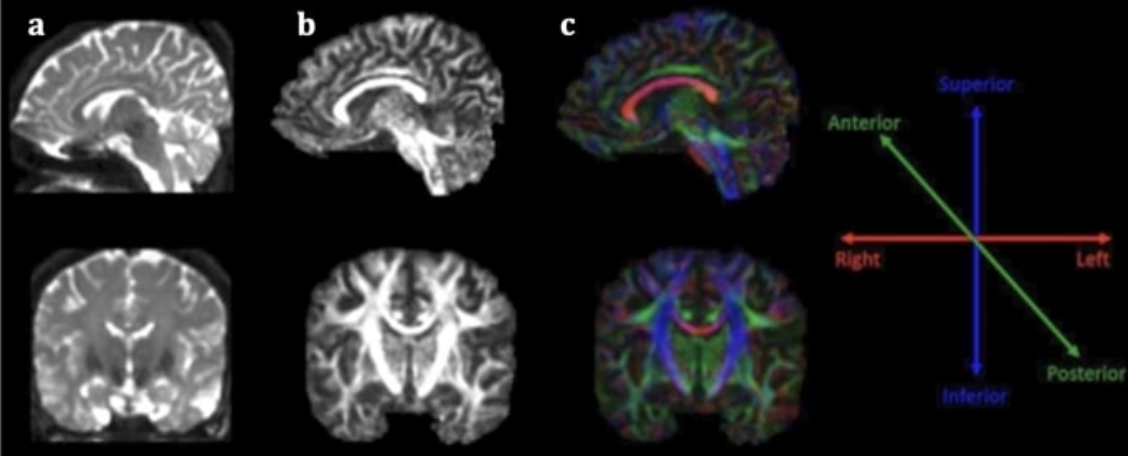
Figure 1. Sagittal (first line) and coronal (second line) section of DTI data ( a ), fractional anisotropy map ( b ) and color fractional anisotropy map ( c ). The color-coding of the white matter tracts in the color fractional anisotropy map follows the assumption: red for left–right-oriented fibers, blue for superior–inferior-oriented fibers and green for anteroposterior-oriented fibers.